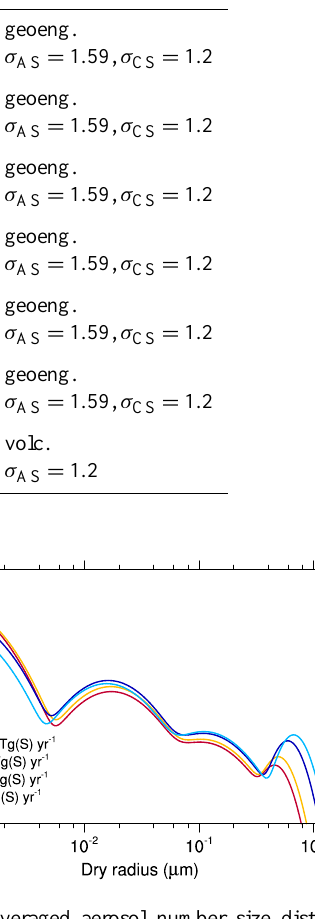
Table 1. Overview of the input parameters for the simulations performed with ECHAM5-HAM. The injection rate differs between the simulations, as well as the injection area and injection height and the mode configuration of the aerosol microphysics. Lonbox is one grid box at the Equator at 120.9 to 123.75 ◦ E. GeoX is a synonym for the injection rates of 1 to 100Tg ( S ) yr − 1 . Simulation Rate Area Height Mode setup Tg ( S ) yr − 1 GeoX 1, 2, 3, 4, 5, 6, 8, 10, 2.8 ◦ N to Eq. geoeng. 20, 30, 40, 50, 70, 100 lonbox 60hPa Geo10-5